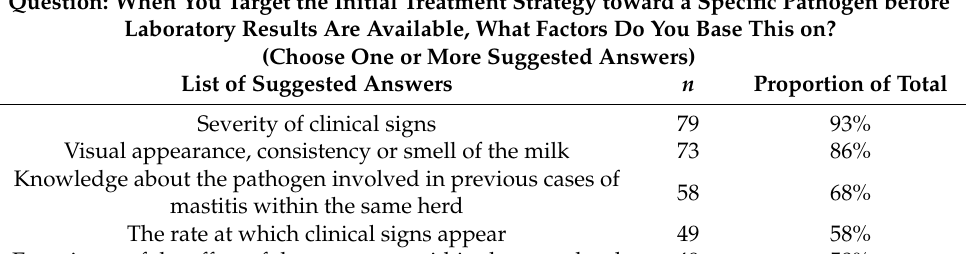
Table 3. Number ( n ) and proportion (%) of respondents who marked the suggested answers about indications used for targeting treatment toward specific pathogens in cases of clinical mastitis. Based on answers from 85 Danish